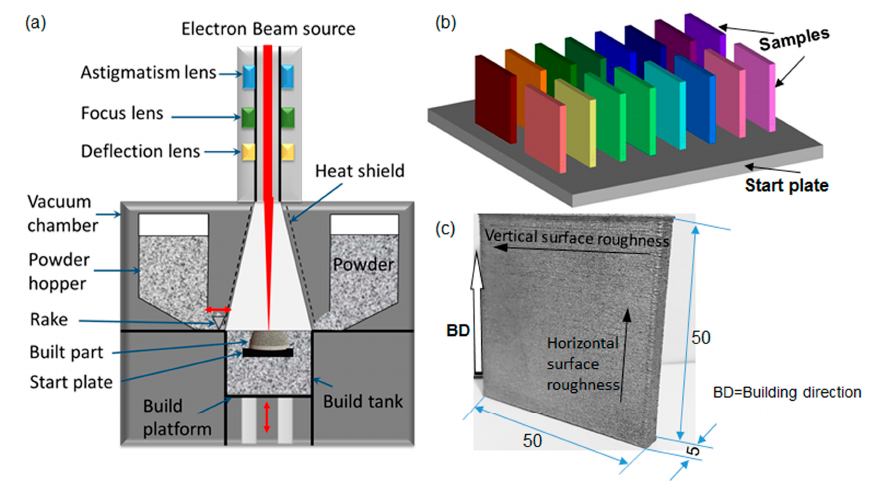
Figure 1. Illustration of ( a ) EBM system; ( b ) sample locations (each color indicated one sample); and ( c ) the picture of the EBM-built sample with dimensions (in mm). The thick arrow indicated the build direction and the thin arrows indicated the directions of the surface roughness measurements.